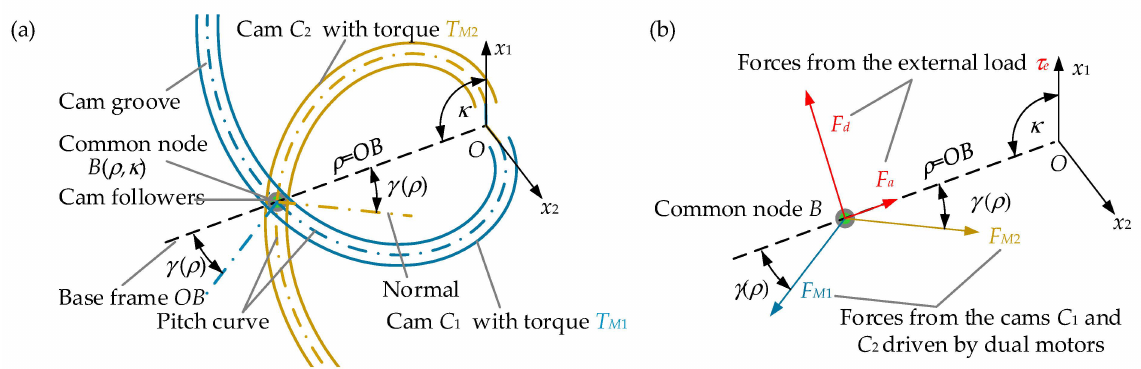
Figure 3. Load distribution modeling schematics ( a ) Cam curve in the part polar coordinate system; ( b ) Static forces at the common